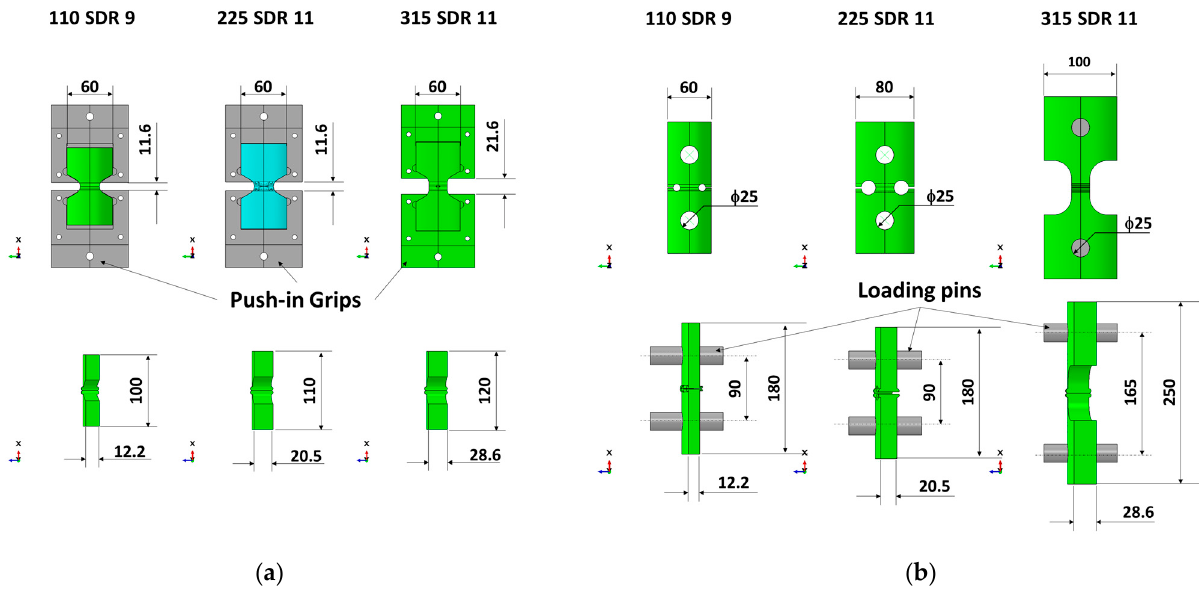
Figure 11. Specimen and grip assembly dimensions for FE analysis (unit: mm): ( a ) TWT; ( b ) WT.